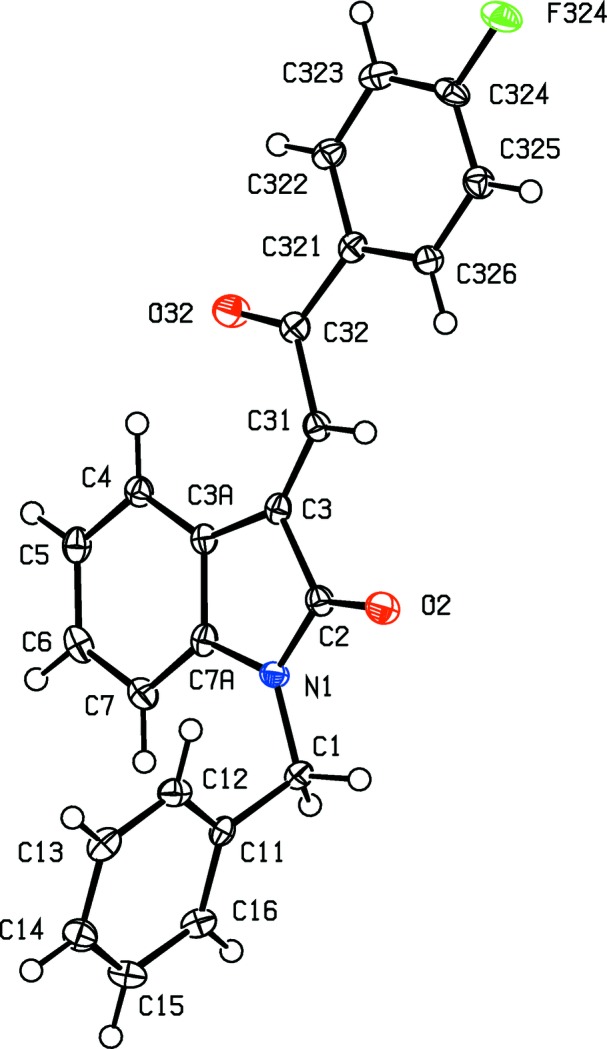
The mol­ecular structure of com­pound (IIa), showing the atom-labelling scheme. Displacement ellipsoids are drawn at the 30% probability level.